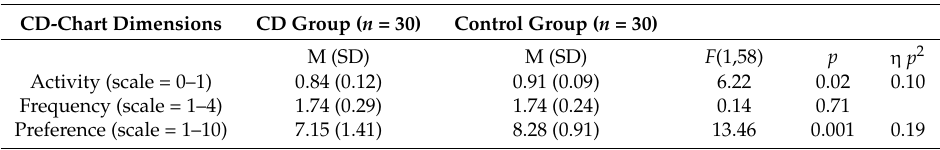
Table 2. Comparison of means and standard deviations between CD group and control group for the four CD-Chart dimensions.